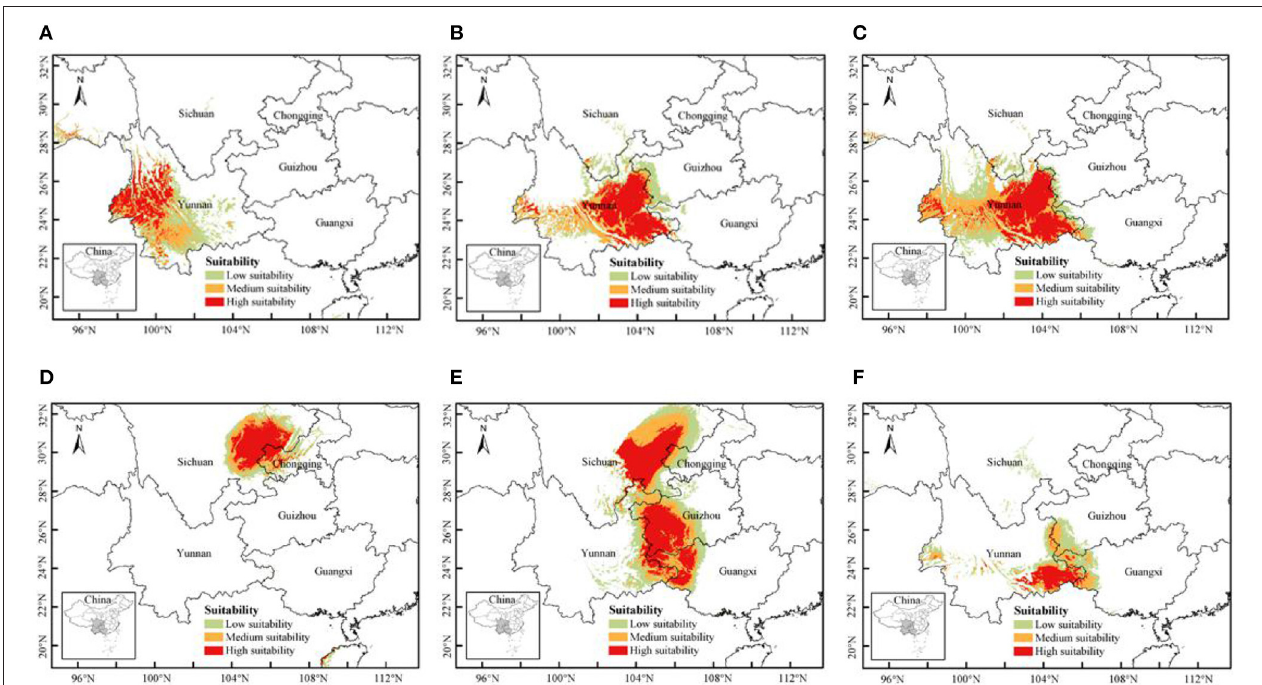
FIGURE 3 | The potential distribution of Panax notoginseng under current climate based on different regionalization model. (A) Hengduan Mountain regionalization, (B) Yunnan-Guizhou Plateau regionalization, (C) Yunnan + Guangxi regionalization, (D) Sichuan Basin regionalization, (E) Sichuan + Chongqing + Guizhou regionalization, and (F) Sichuan + Chongqing + Guizhou + Guangxi + Wenshan regionalization.